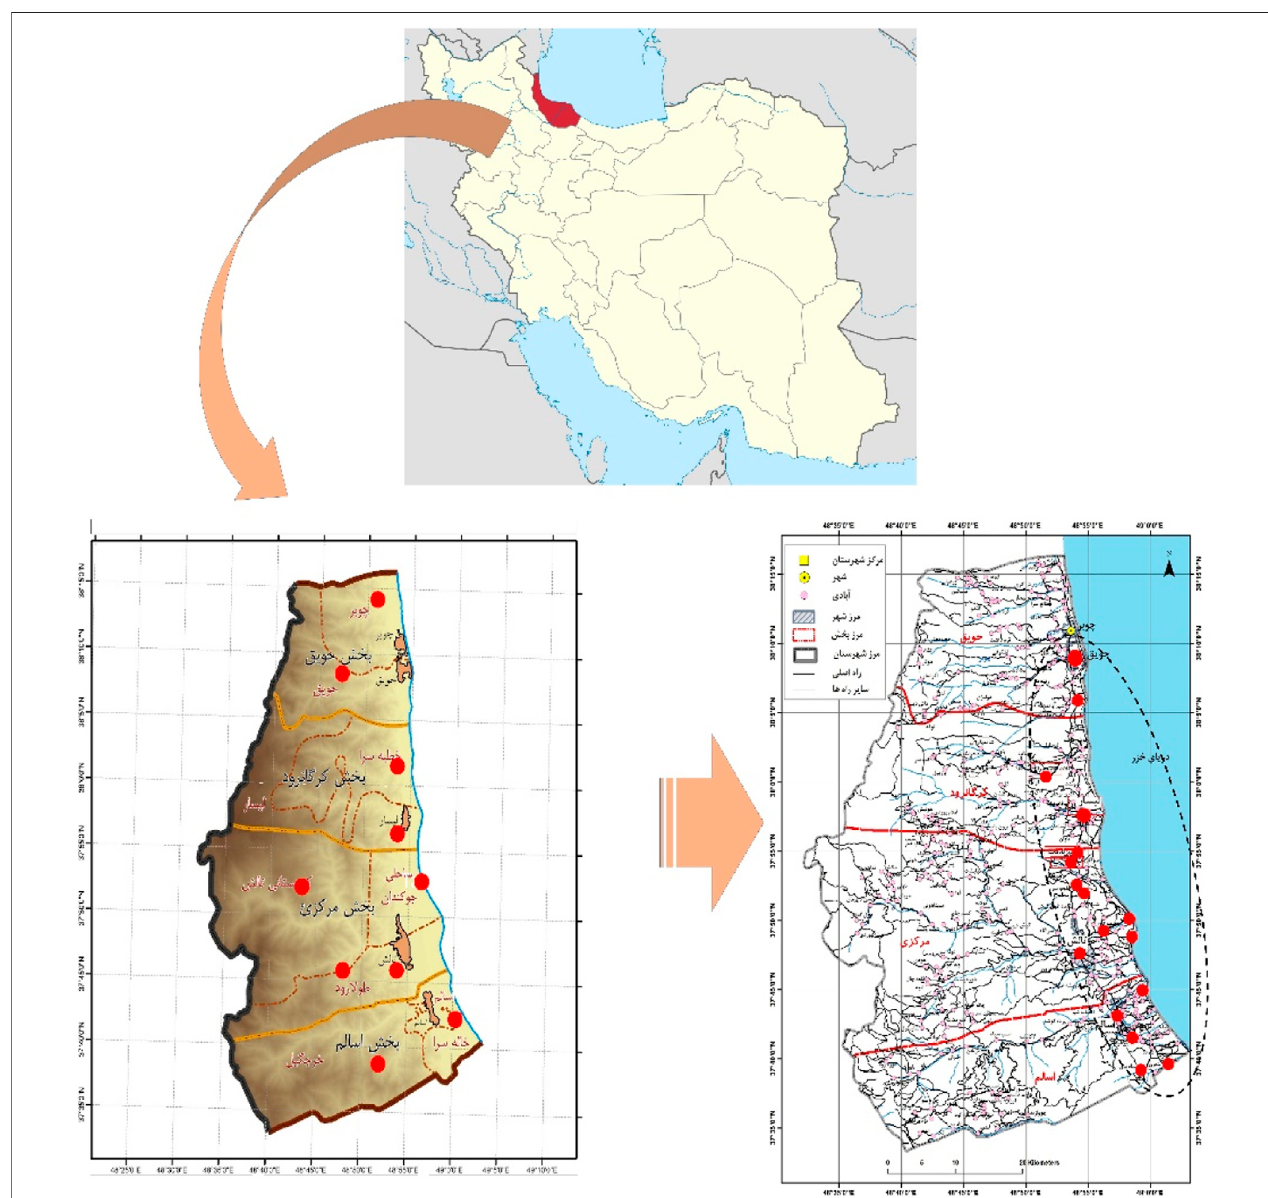
FIGURE 1 | Research trend chart, source: